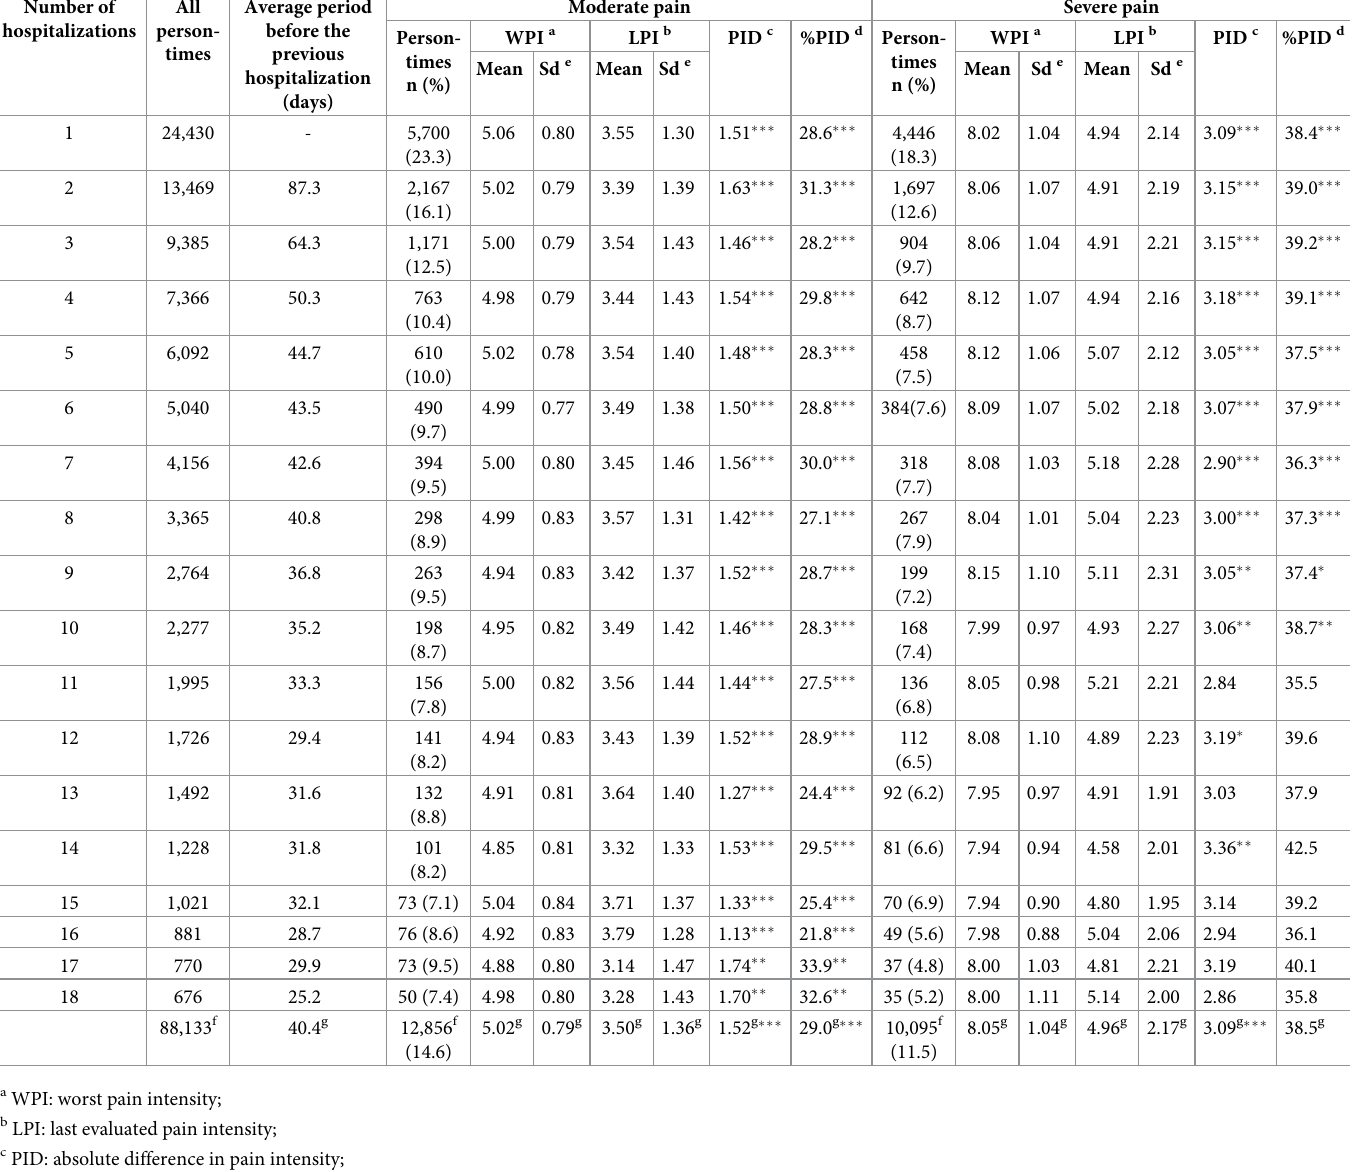
Table 1. Pain intensity values for patients with moderate pain or severe pain during each hospitalization. Number of